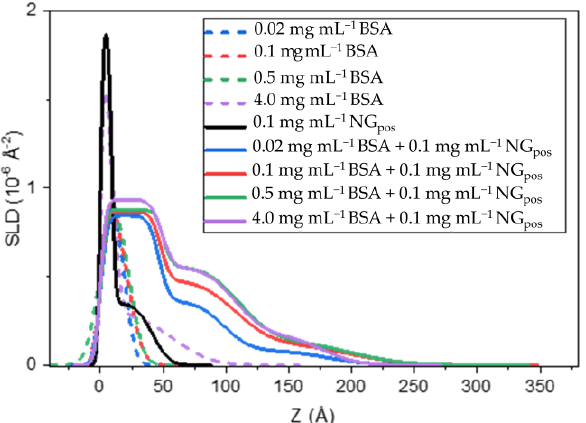
Figure 2. SLD profiles of BSA (dashed lines), NG pos (black), and BSA-NG pos mixtures (solid lines) at the air/water interface in CMAir contrast. BSA was used in concentrations between 0.02 – 4 mg mL −1 , while NG pos was kept at 0.1 mg mL −1 . The NG pos is made of 60 molar% d3AM — 20 molar% MBA — 20 molar% GUA.